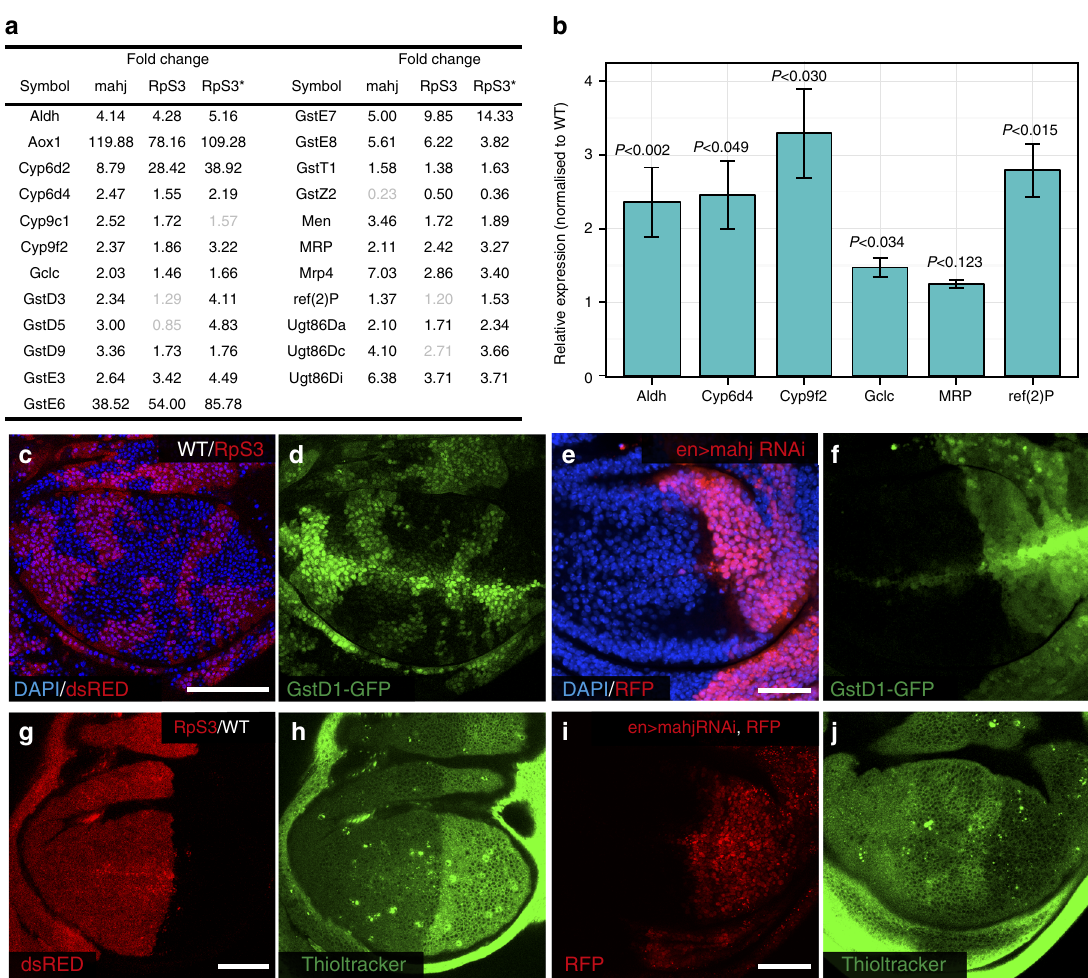
Fig. 5 Prospective loser cells activate the oxidative stress response before and during competition. a List of genes involved in the oxidative stress response upregulated in the indicated prospective loser genotypes (fold changes with false discovery rate > 0.1 are in grey ). b Quantitative PCR analysis showing for selected genes from the list in a the expression levels in wing discs overexpressing Nrf2 relative to wild-type (WT), P values according to Welch t -test; error bars: s.e.m. c , d Expression of the Nrf2 reporter GstD1 -GFP ( green , d ) in wing discs mosaic for RpS3 + / − cells (ds-RED-positive) and WT cells (ds-RED- negative, c ). e , f GstD1 -GFP reporter expression ( green , f ) in wing discs expressing mahj RNAi in the P compartment (RFP-positive; e ). g , h Thioltracker staining ( green , h ) in composite wing discs carrying a (ds-RED-positive) RpS3 + / − A compartment and a WT (ds-RED-negative) P compartment ( g ). i , j Thioltracker staining ( green , j ) in wing discs expressing mahj RNAi in the P compartment (RFP-positive; i ). Thioltracker levels are lower in the mahj RNAi compartment in 10 out of 18 wing discs analysed (56% penetrance). Detailed genotypes for each fi gure panel are listed in Supplementary Table